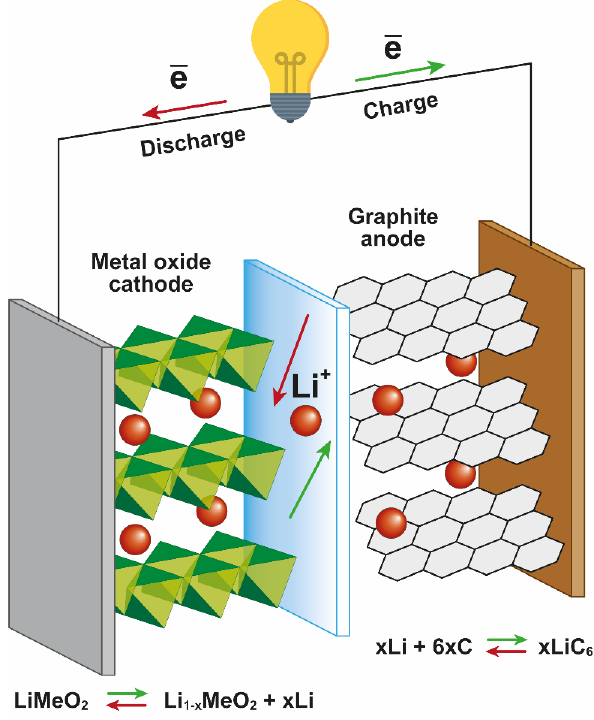
Figure 1. Schematic representation of a Li-ion battery cell.